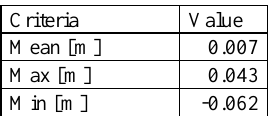
Table 4. Results of the plane-to-plane-comparisons of 12 UAS- planes to